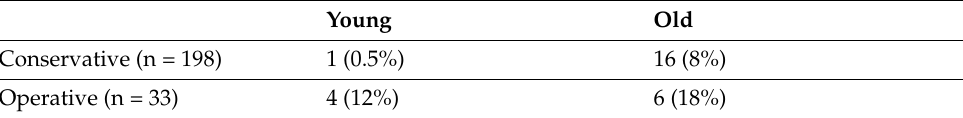
Table 3. Number of deteriorations in mobility at latest follow-up compared to mobility before